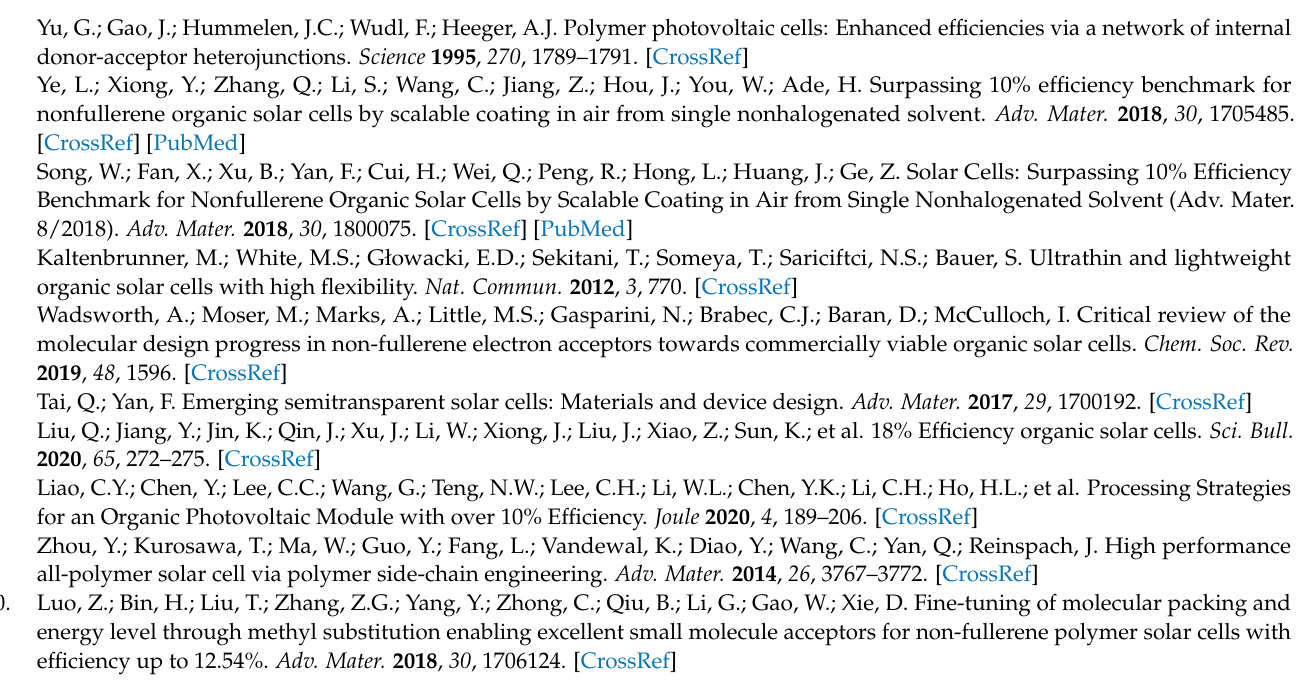
Figure S2: FTIR spectra of NDI-OH films without and with annealing; Figure S3: Steady state photolu- minescence for PC71BM/ILs film (a); excitation wavelength 500 nm. Steady state photoluminescence for ITIC/ILs film (b); excitation wavelength 700 nm; Figure S4: J-V curves in dark conditions of the devices. FA-based (left) and NFA-based PSCs (right); Table S1. Thicknesses are an average out of 4 measurements of the glass/NDI-OH spin coated samples. Figure of merit values are an average out of 6 pixels each